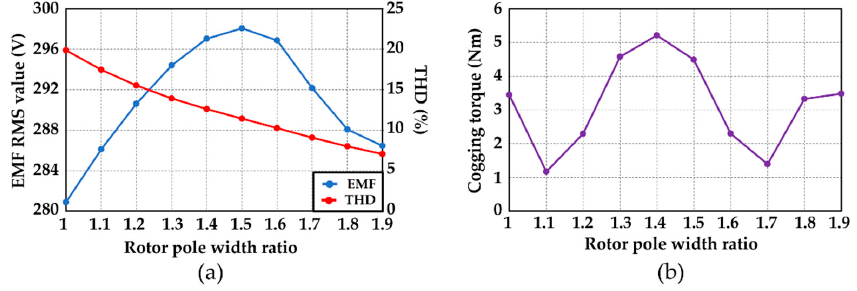
Figure 6. Influence of the rotor pole width on the ( a ) EMF profile and ( b ) cogging torque of the 12-stator/19-rotor V-shaped FSPM generators . 12-stator/19-rotor V-shaped FSPM